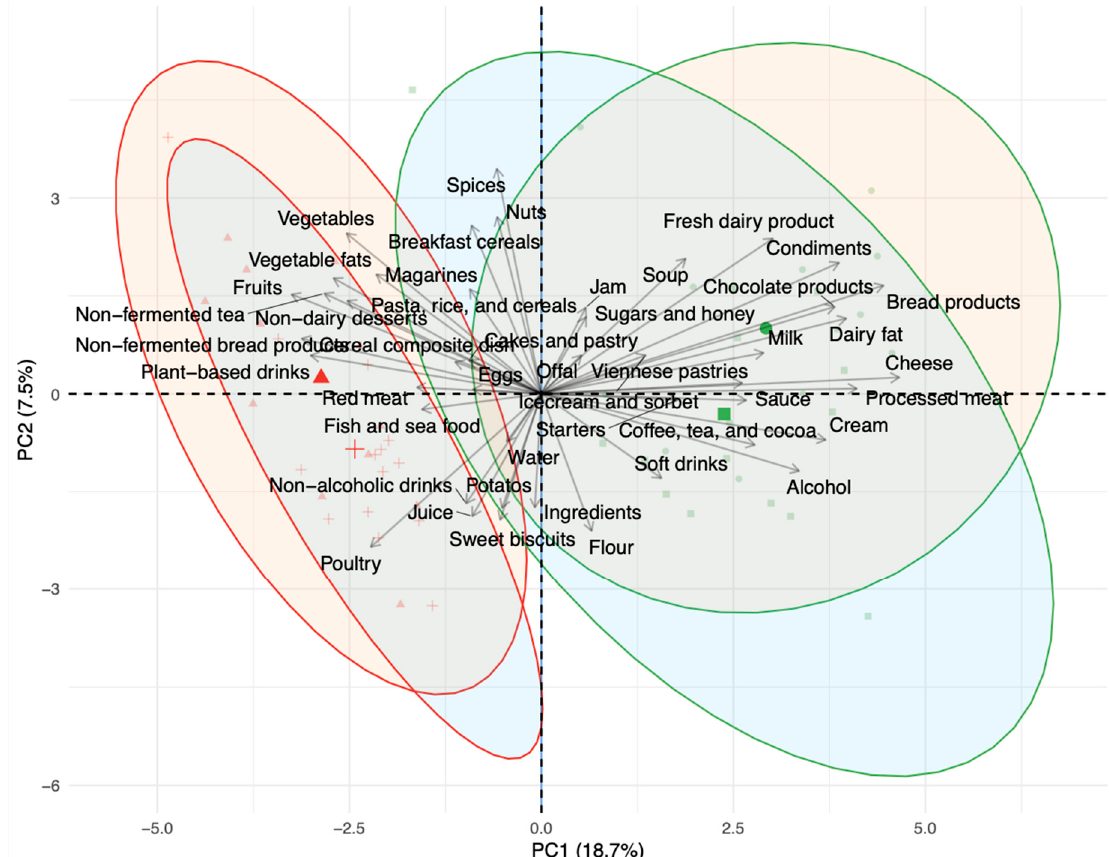
Figure 2. Biplot of principal component analysis (PCA) with a loading plot of daily intake of total food groups for the young adults (YA) and older adults (OA) groups during the observation (OB) and semi-controlled diet (SC) phases. Symbols define the group and period: circles OA, OB phase; squares YA, OB phase; triangles OA, SC phase; crosses YA, SC phase. Ellipse outline represents the period: OB phase in green, SC in red. Ellipse fill represents the group: OA group, orange; YA group, blue. PC, principal component.